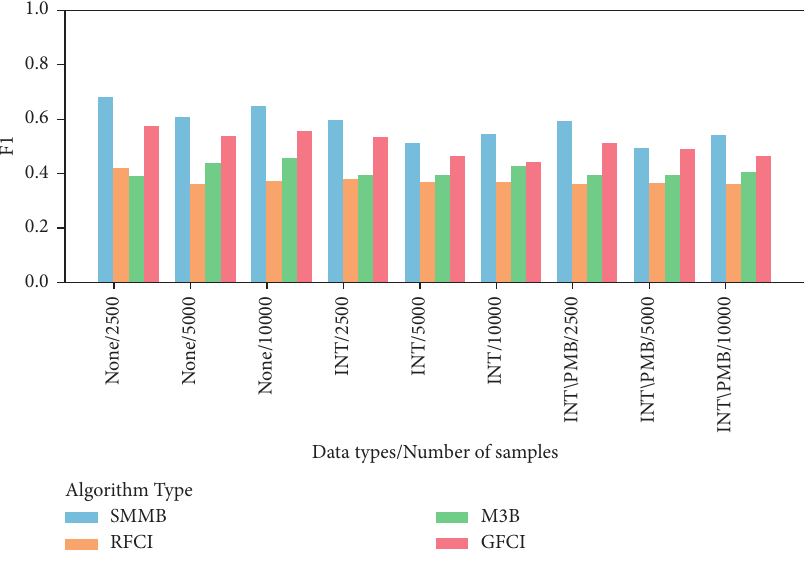
Figure 6: Comparison of SMMB, RFCI, M3B, and GFCI in F